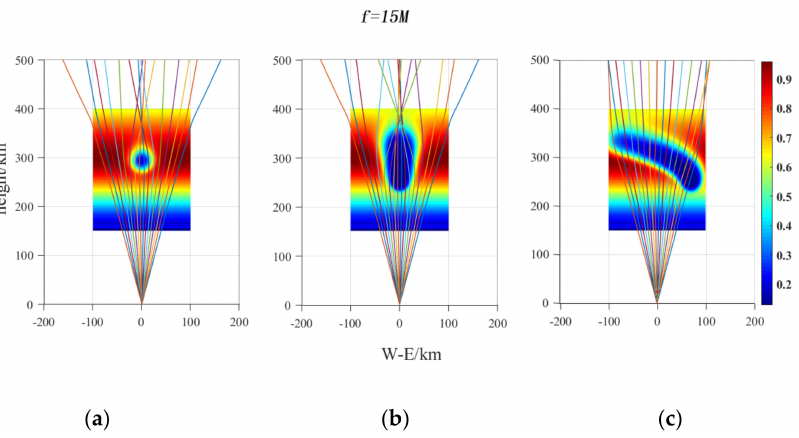
Figure 11. 3D ray-tracing simulation of 15 MHz short wave propagation path after 100 s of H 2 O re- leased by rocket under different flight paths (electron density unit: 10 6 cm − 3 ); ( a ) 300 km fixed − point release, ( b ) 250 − 350 km vertical path, ( c ) 250 − 350 km parabolic